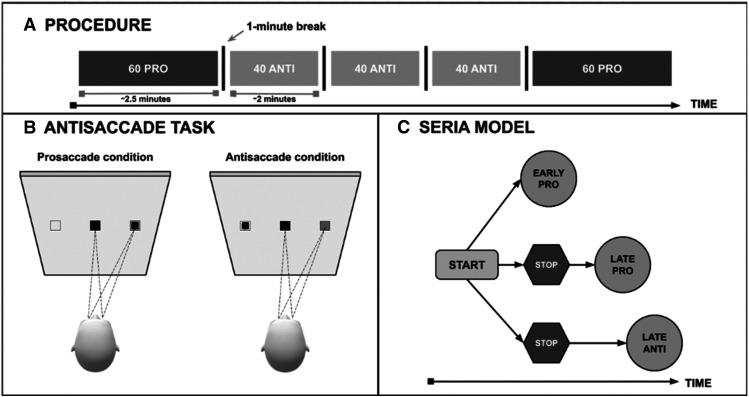
A, The experimental procedure of a single run, consisting of prosaccade task (PRO) and antisaccade task (ANTI) blocks, which each consisted of either 40 or 60 trials per block. There was 1 min between each block. B, Schematic top view of the experimental setup and gaze behavior during a prosaccade and antisaccade condition trial. The black square represents the target fixation in the center of the screen, and the smaller black square represents the peripheral stimulus (cue). The peripheral stimulus is presented 1000 ms on the screen and starts after a duration of the target fixation of 800–1200 ms. C, The sequence of latent events assumed by the SERIA model, generating as output either early prosaccades (EARLY PRO), late prosaccades (LATE PRO), or antisaccade events (LATE ANTI).